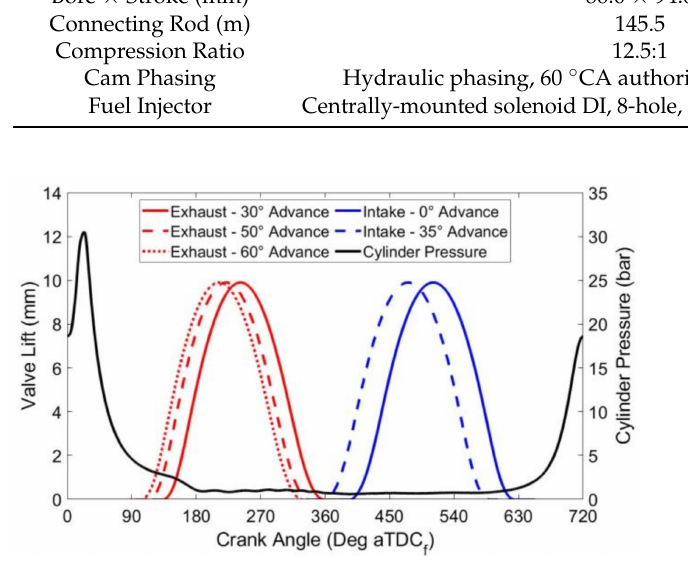
Figure 1. Intake and exhaust valve timings as a function of cam